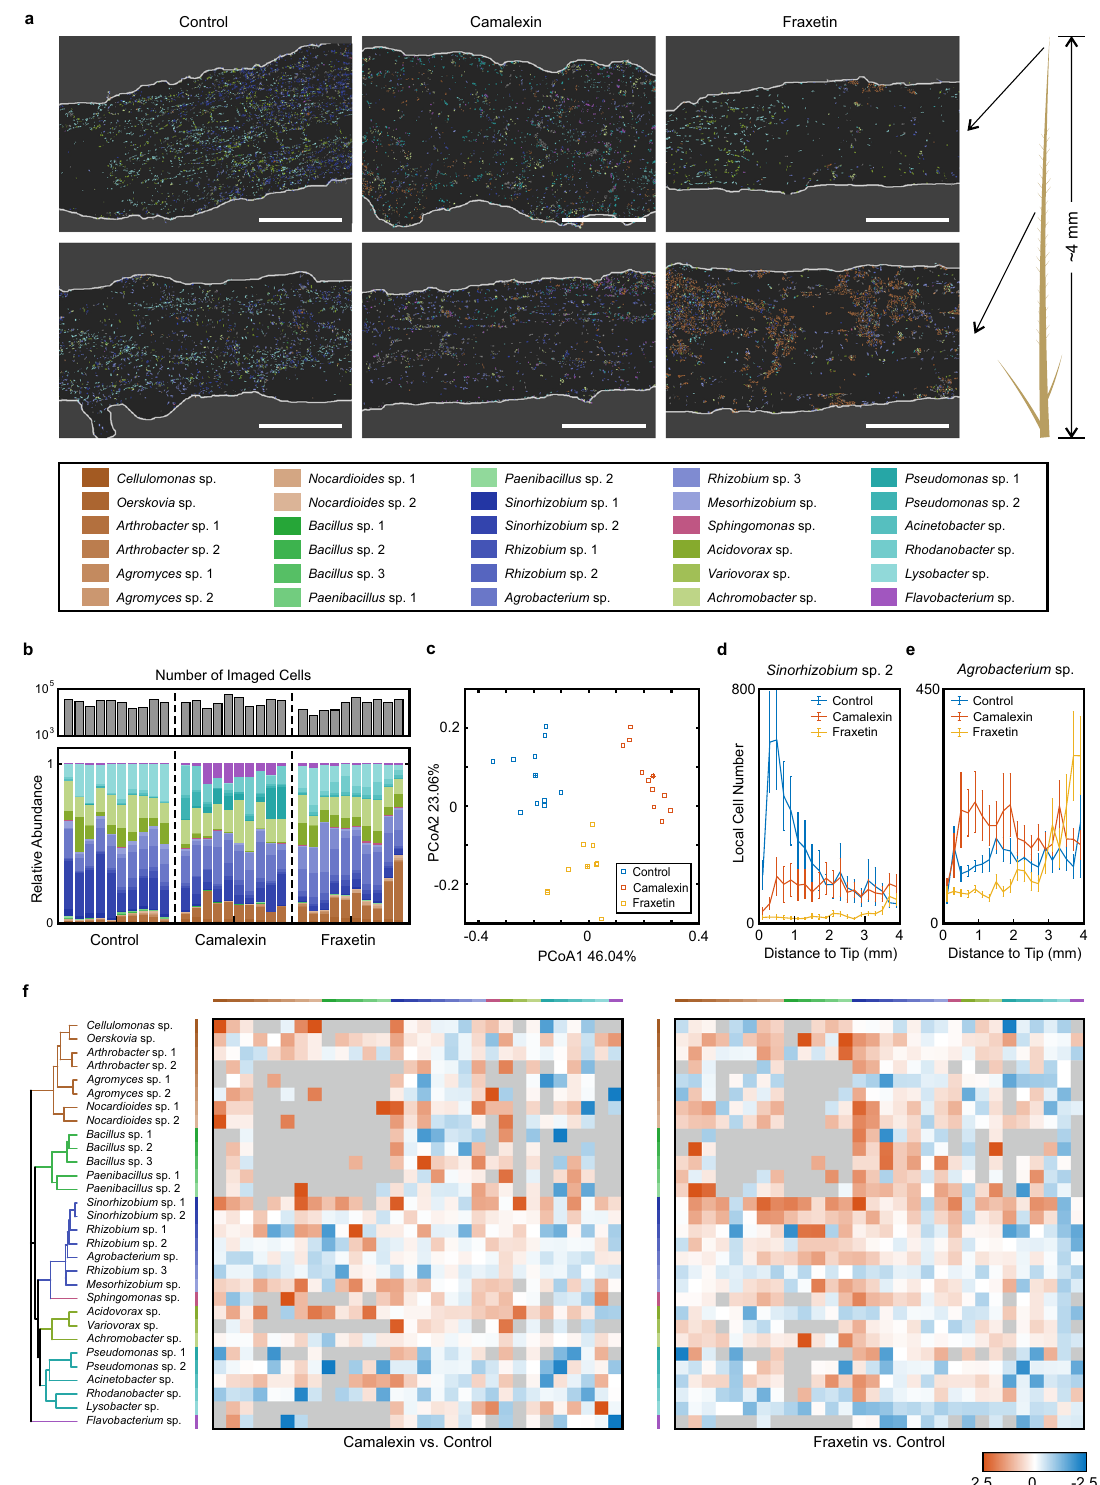
Supplementary Fig. 14c). For example, the abundance of Mesorhizo- bium sp. decreased under camalexin/fraxetein treatment, consistent withtheobservationthatitsgrowthwasstrongly inhibitedbytheplant metabolites in